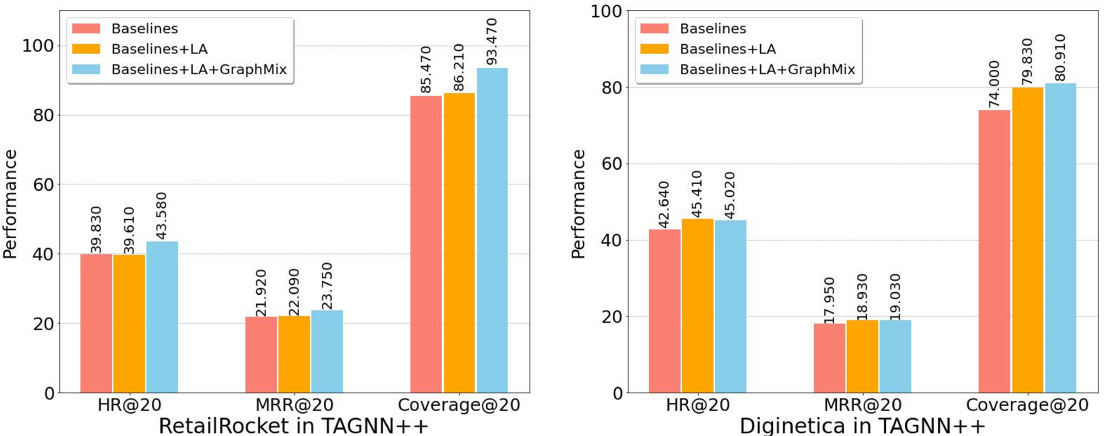
Figure 3. Comparing performance in two different datasets in the TAGNN++ model. Compare to baseline model performance, applying LA (Logit Averaging) improves performances in every